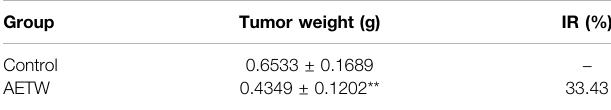
TABLE 2 | Mice body weight of the two experiment groups (control, AETW).